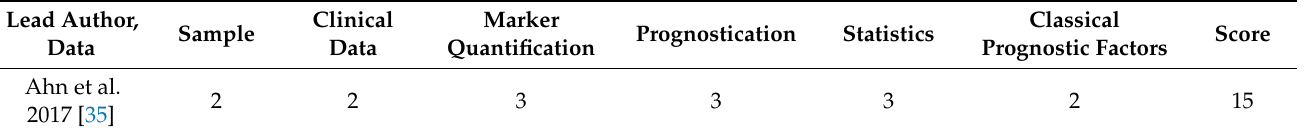
Table 3. Assessment of the risk of bias within the studies. Scores 8 to 10 = low quality, 11 to 14 = medium quality, and 15 to 18 = high